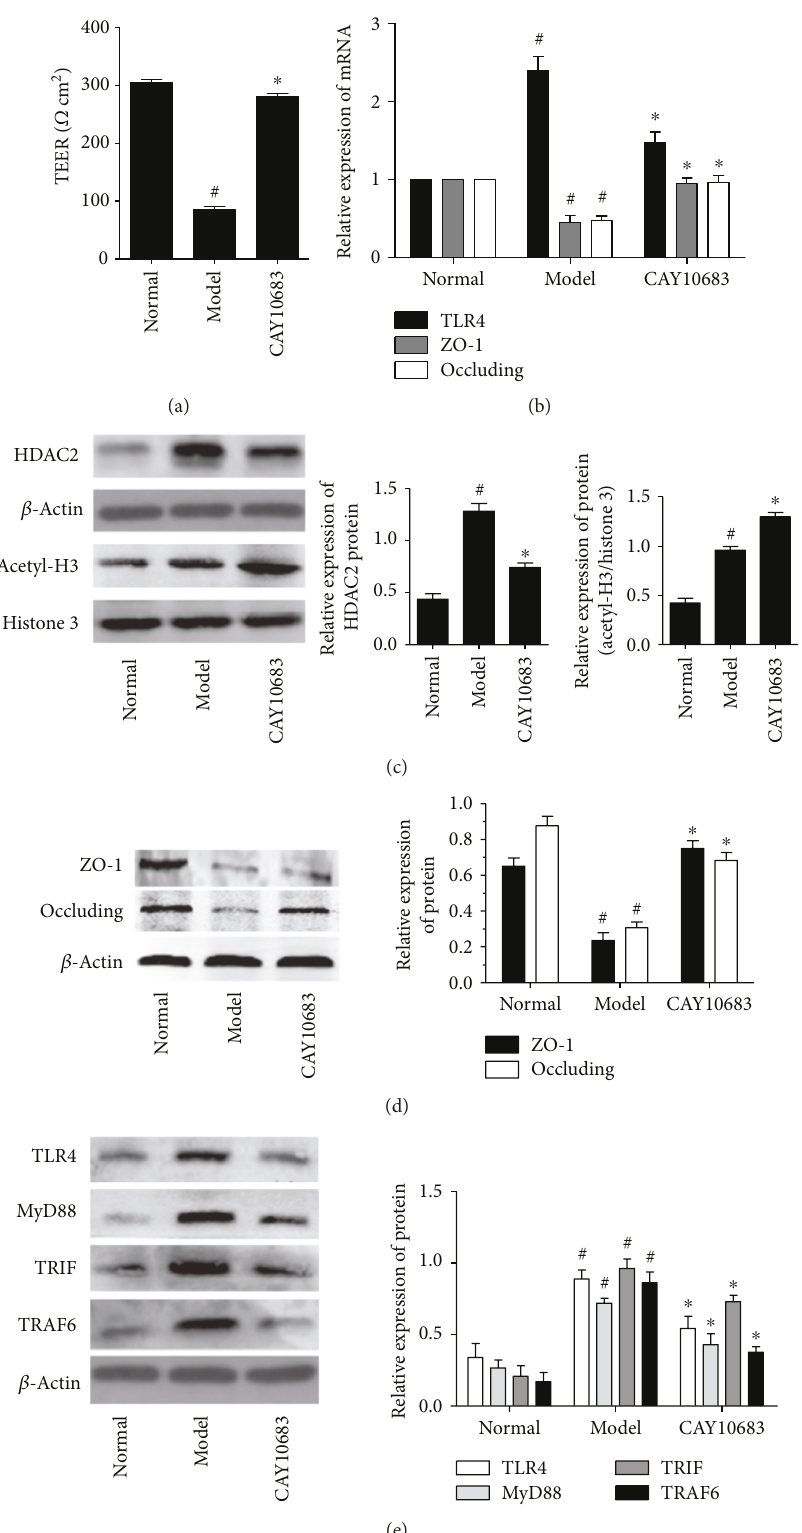
Figure 2: (a) E ff ect of CAY10683 on TEER in LPS-stimulated NCM460 cells. (b) E ff ect of CAY10683 on the mRNA expression of TLR4, ZO- 1, and occludin in LPS-stimulated NCM460 cell. (c) E ff ect of CAY10683 on HDAC2 and acetyl-H3 in LPS-stimulated NCM460 cells. (d) E ff ect of CAY10683 on the protein levels of ZO-1 and occludin in LPS-stimulated NCM460 cell. (e) E ff ect of CAY10683 on the TLR4, MyD88, TRIF, and TRAF6 protein levels in LPS-stimulated NCM460 cells. Values are expressed as mean ± SD. # P < 0 05 , compared with normal group; ∗ P < 0 05 , compared with model